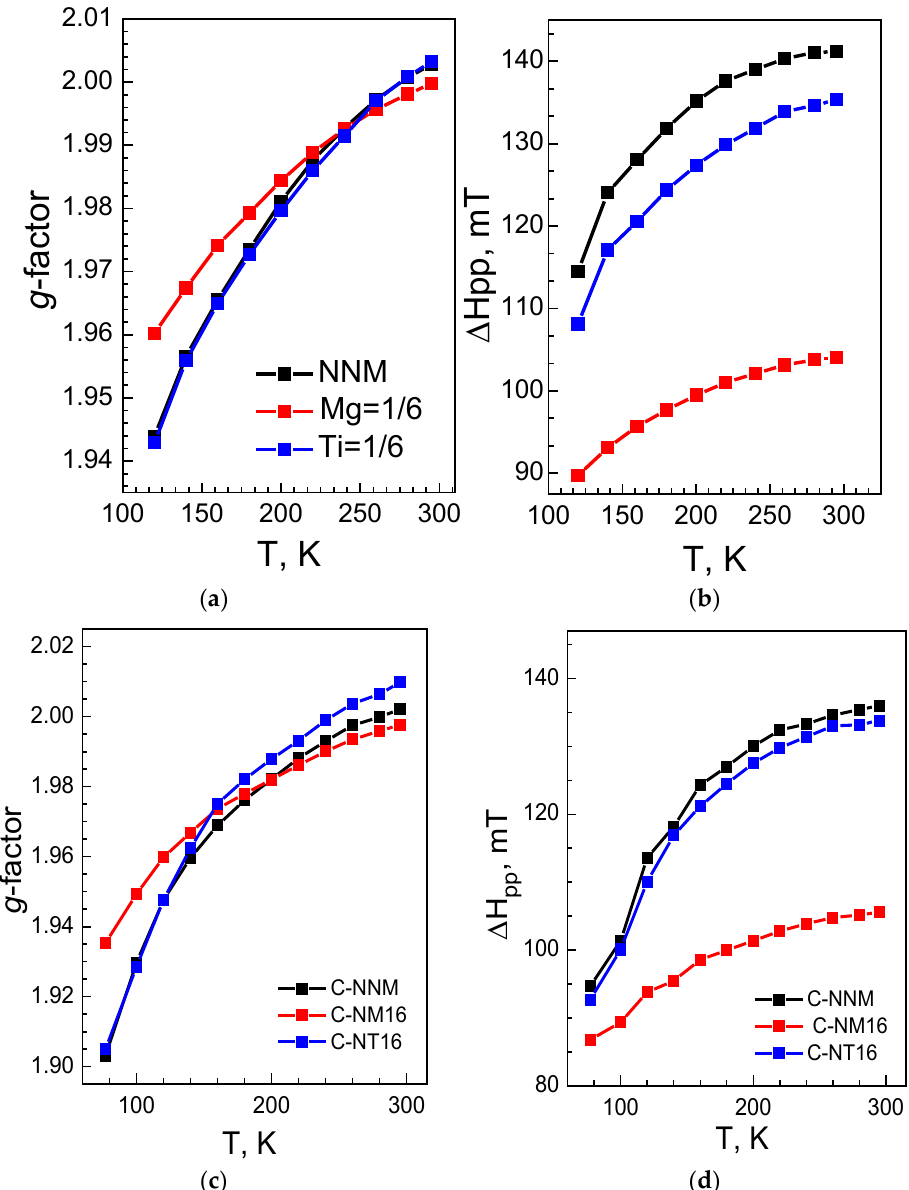
Figure 1. Temperature dependence of the g -factor and EPR line width ( ∆ Hpp) of NNM, NM16, NT16 ( a,b ) and their CeO 2 -treated analogues ( c,d ).